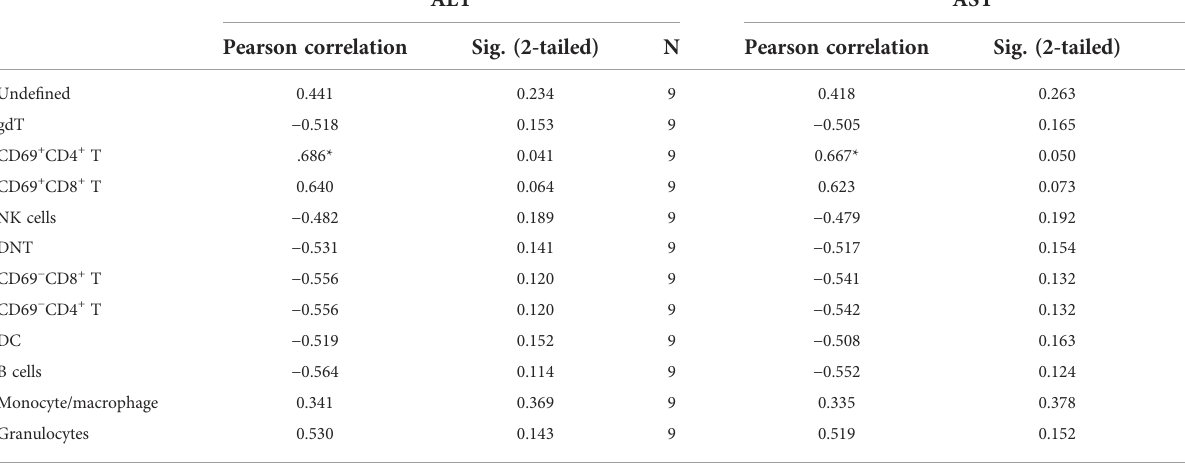
TABLE 1 Correlation of CD45 + immune cells subpopulations with ALT and AST.